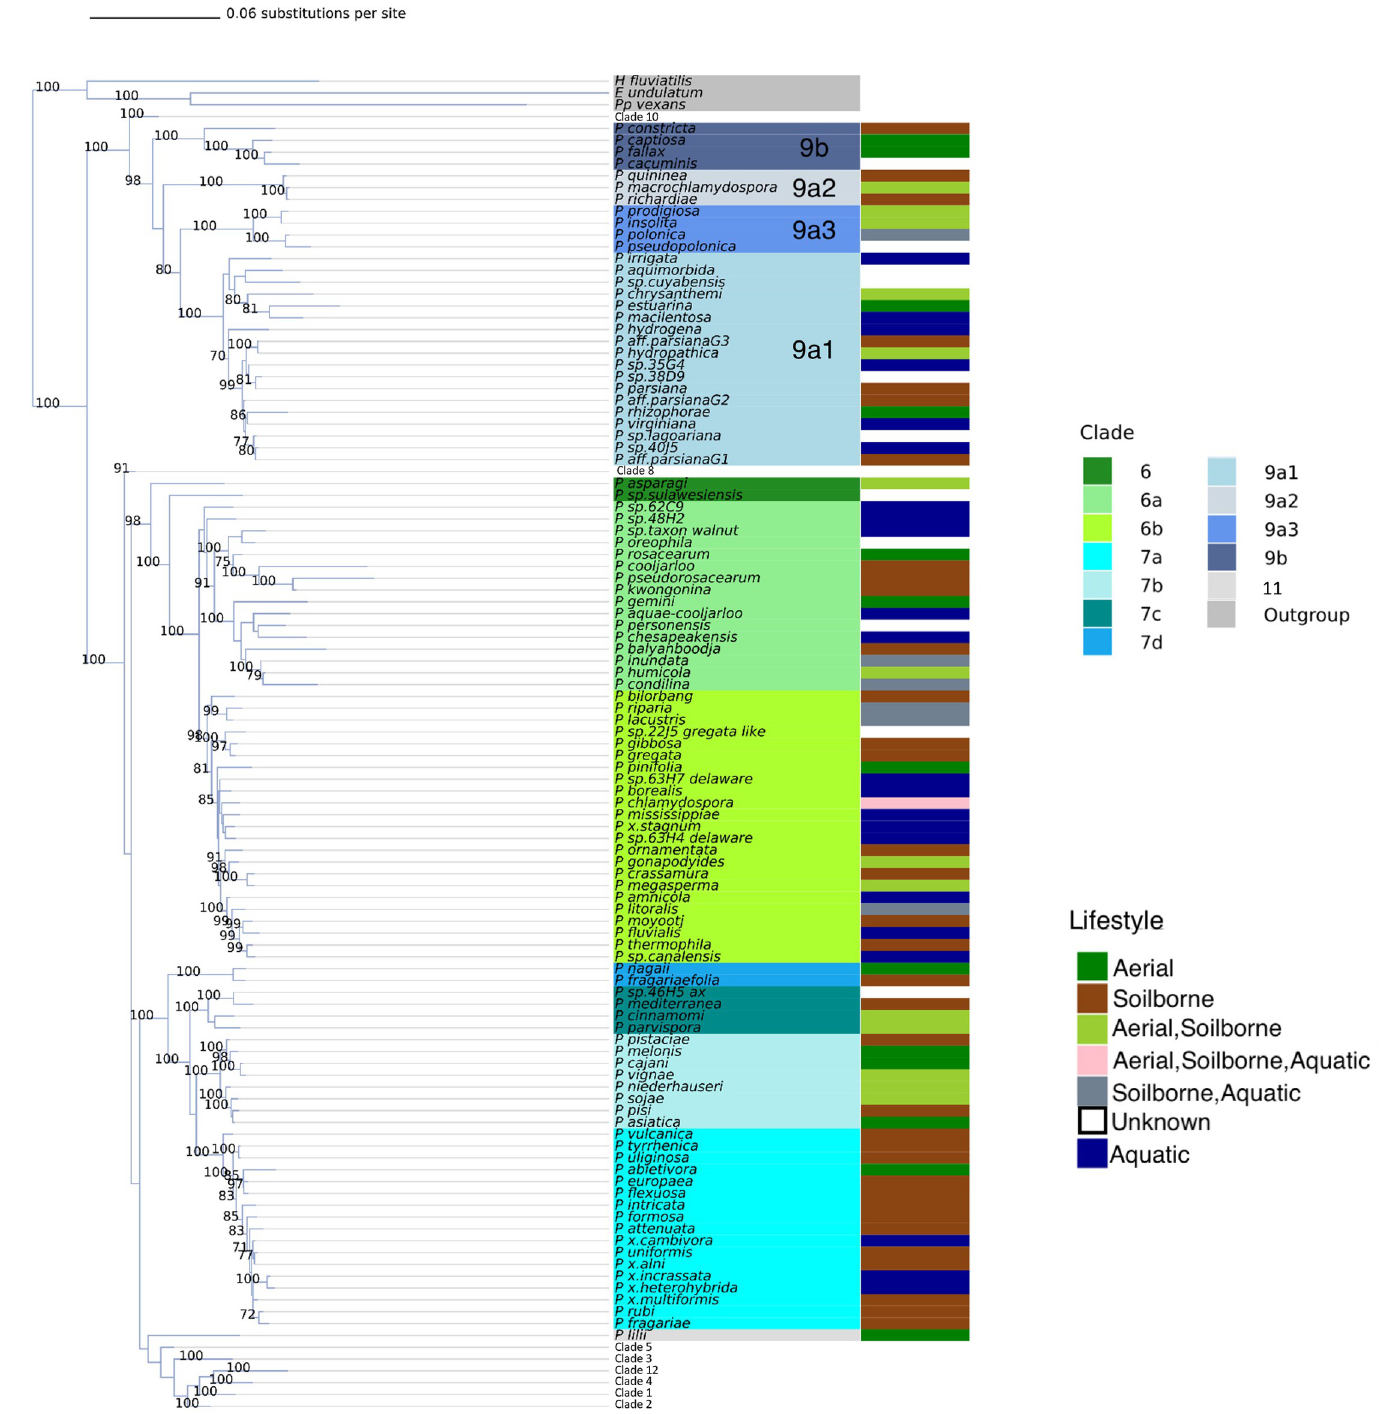
Fig 6. Phylogeny of Phytophthora clades 6, 7, and 9. Collapsed phylogeny of the genus Phytophthora showing 6 (green), 7 (teal), and 9 (blue) in detail. Subclade values are shown as variations in color hue. Phylogeny is inferred using maximum likelihood and 1,000 bootstrap replicates for an alignment of 8 concatenated nuclear loci. Bootstrap values (in percent) are shown for each branch. The branches in the tree are drawn to scale and the scale bar represents 0.06 substitutions per site.